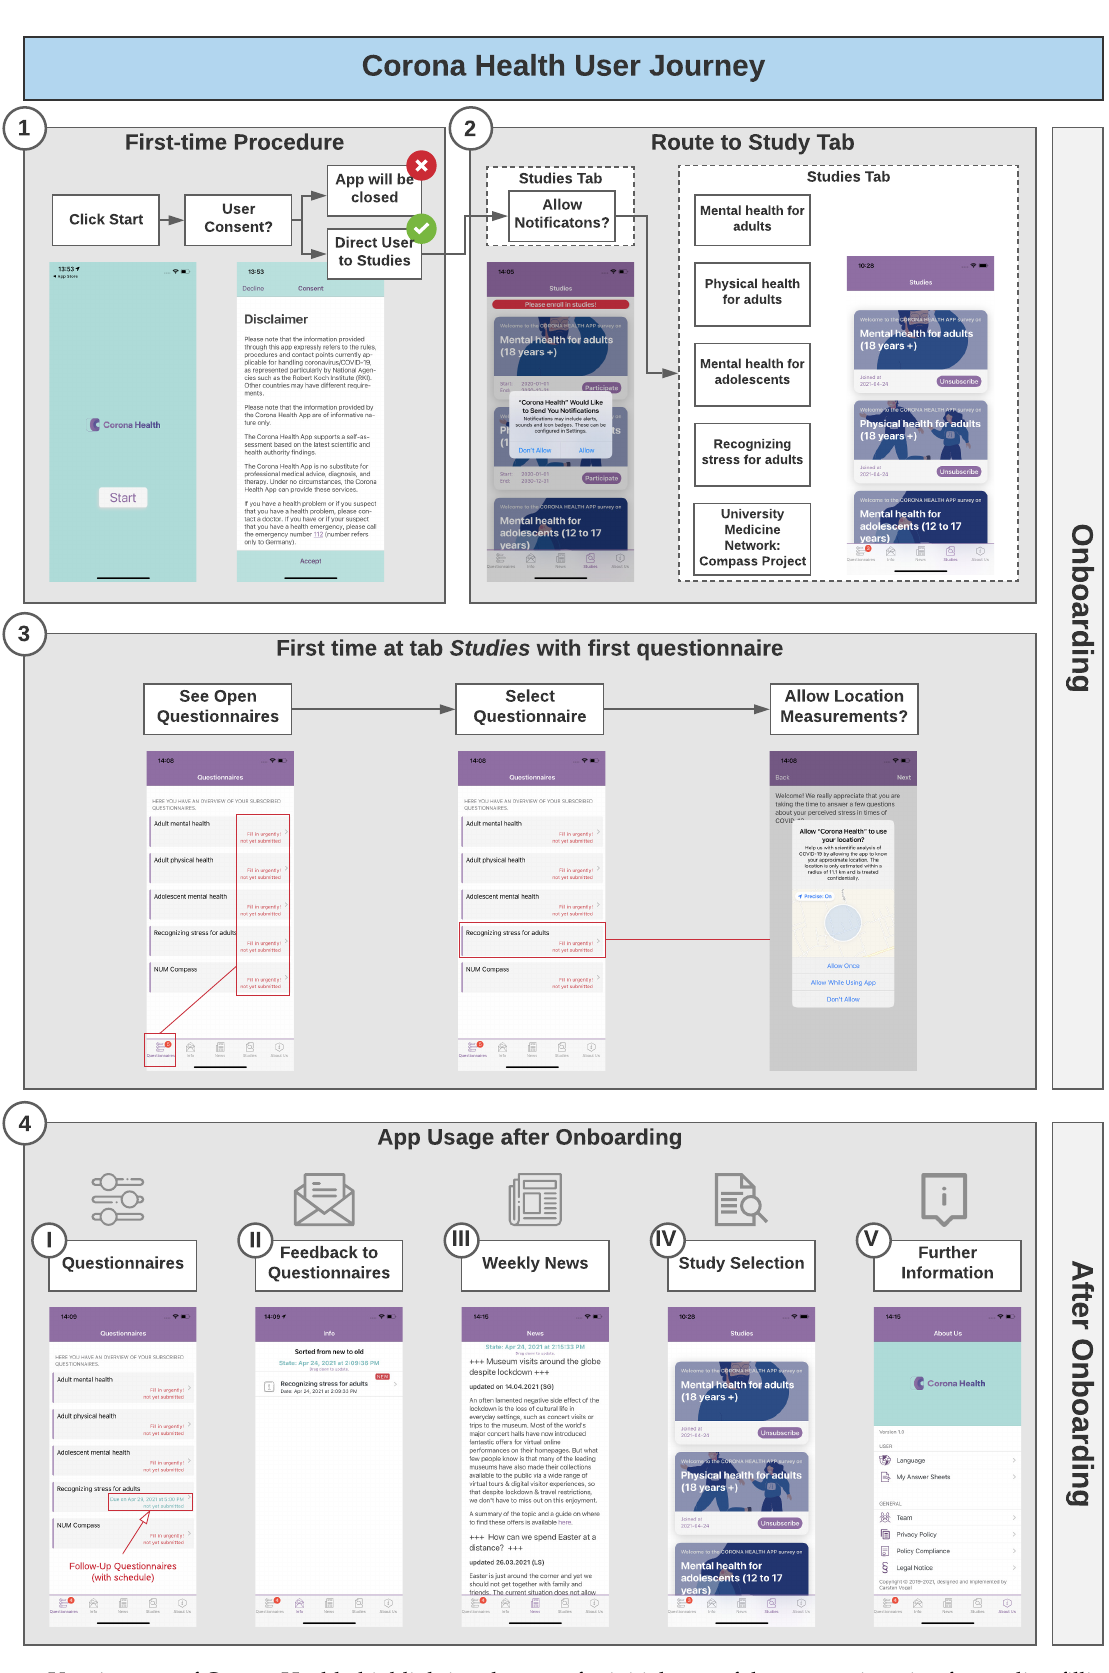
Figure 1. User journey of Corona Health, highlighting the steps for initial start of the app, registration for studies, filling out baseline and follow-up